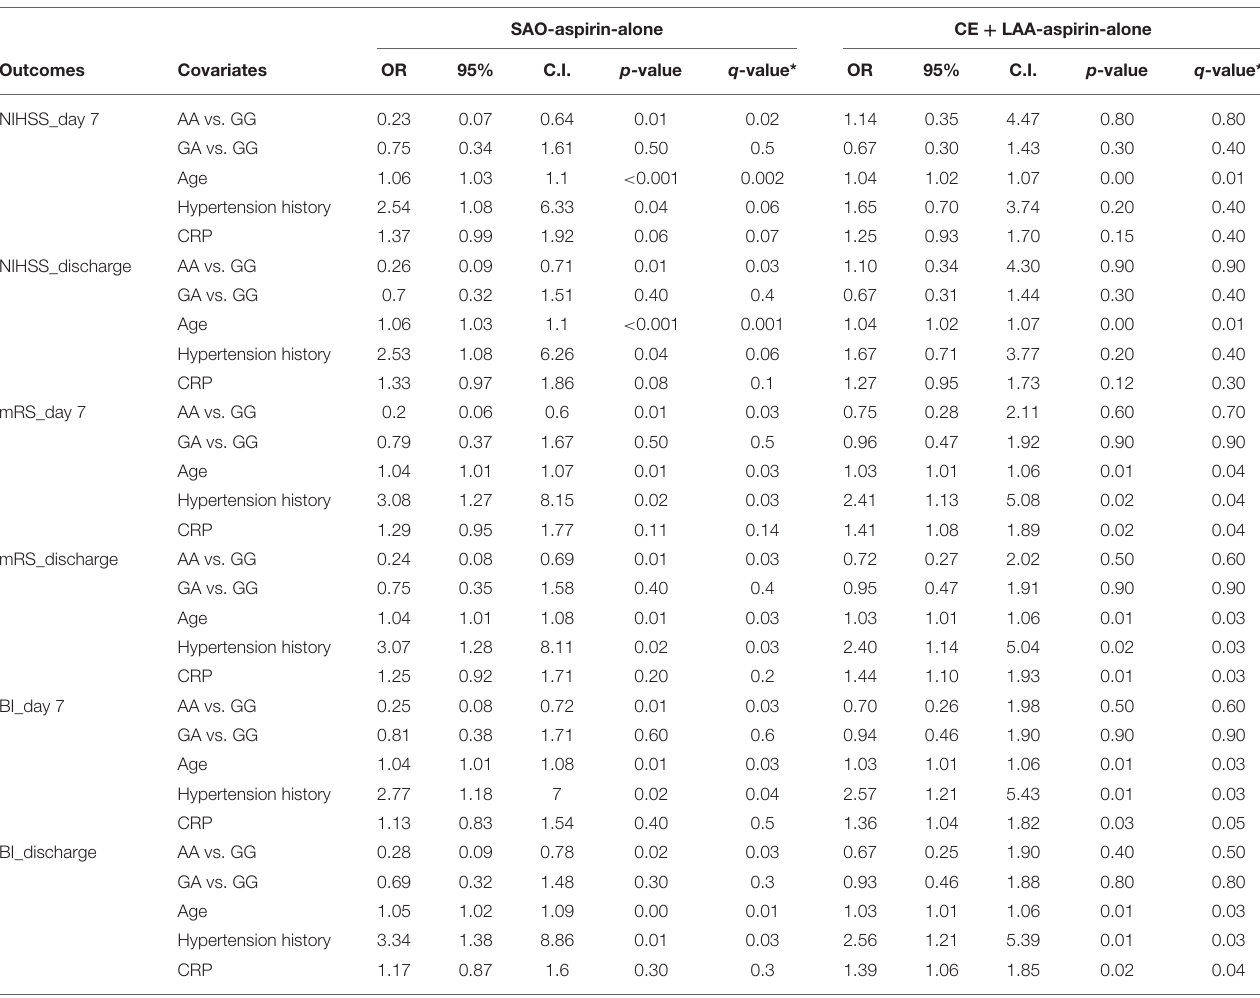
TABLE 4 | Outcome association analysis using multivariable logistic regression models. SAO-aspirin-alone CE +